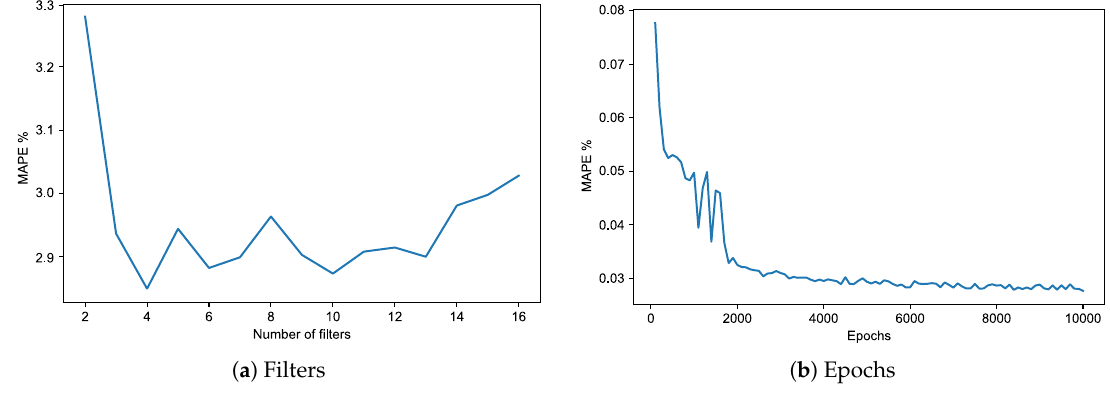
Figure 7. Training error (MAPE) of the